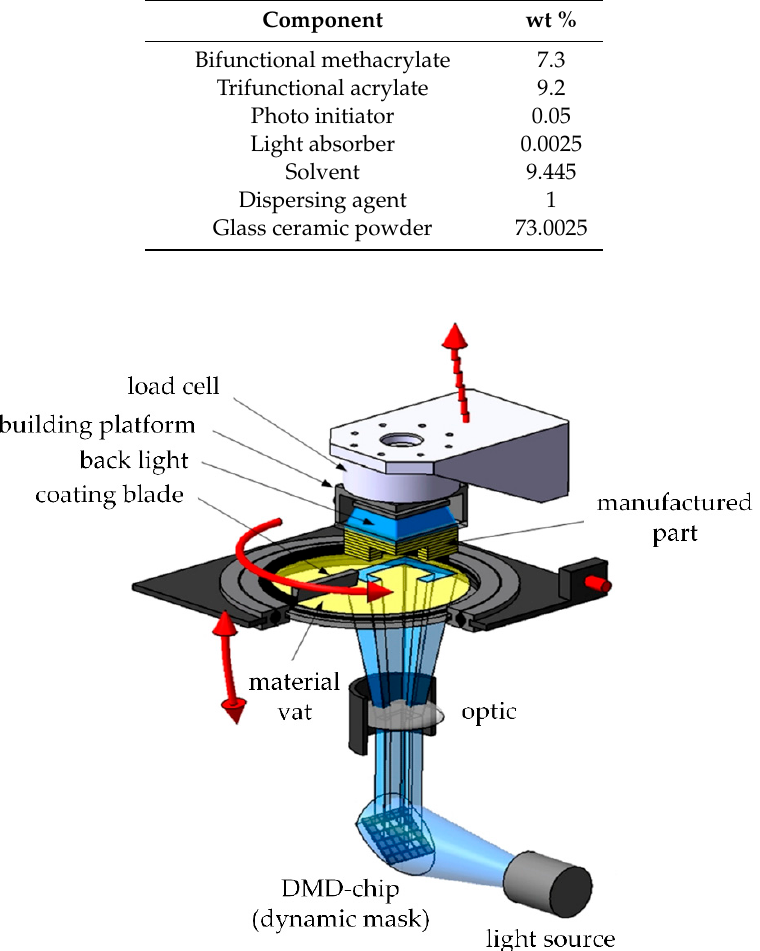
Table 2. The main components of the slurry.